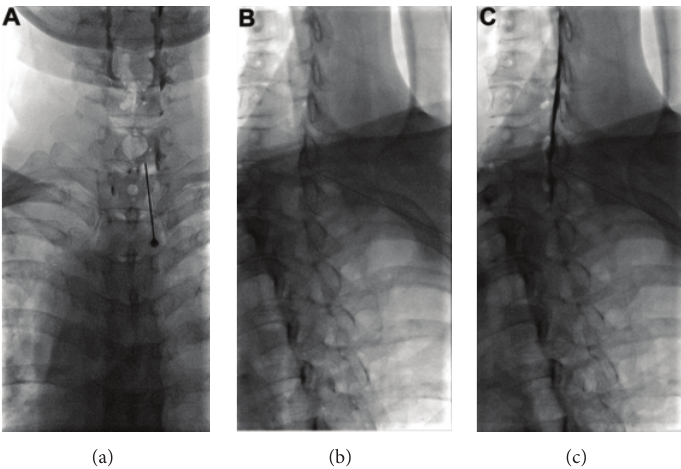
Figure 1: AP and the contralateral oblique views under fluoroscopy. AP view (a) and the contralateral oblique view at 50 degrees ((b) and (c)) under fluoroscopy; the contralateral laminae are seen in complete cross-section view ((b) and (c)). The needle can be seen transversing between the inferior and superior laminae with the needle tip directed toward the spinolaminar line (b). And epidural space was confirmed with contrast medium injection